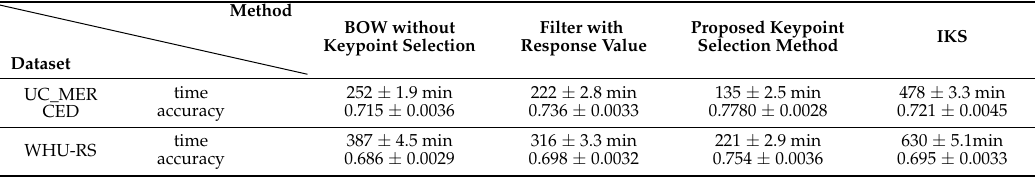
Table 2. Comparison in average computational time for vector quantization and classification accuracy along with their standard deviation for both